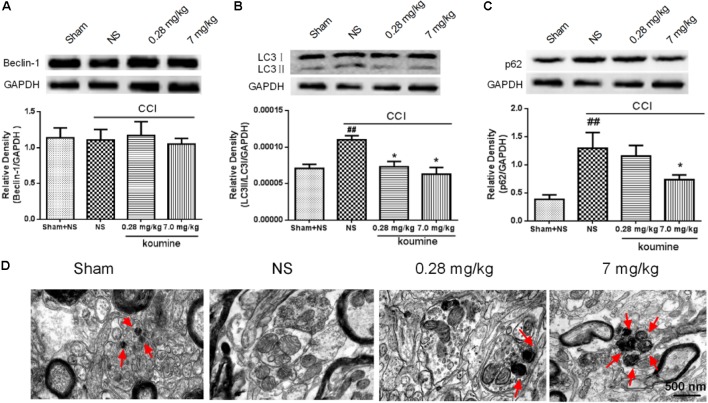
Koumine promoted autophagy in CCI rats. Beclin 1 (A), LC3 (B), and p62 (C) levels were detected by Western blot in the spinal cord. (D) Spinal cord sections were analyzed by light microscopy electron microscope (scale bar = 500 nm), double layer or multilayer membrane and inclusions are the characteristics of the autophagosome structure which contains mitochondria, endoplasmic reticulum, ribosome, and other cytoplasm components (red arrow). ##P < 0.05 versus sham group. ∗P < 0.05 versus vehicle control group by one-way ANOVA followed by LSD test.